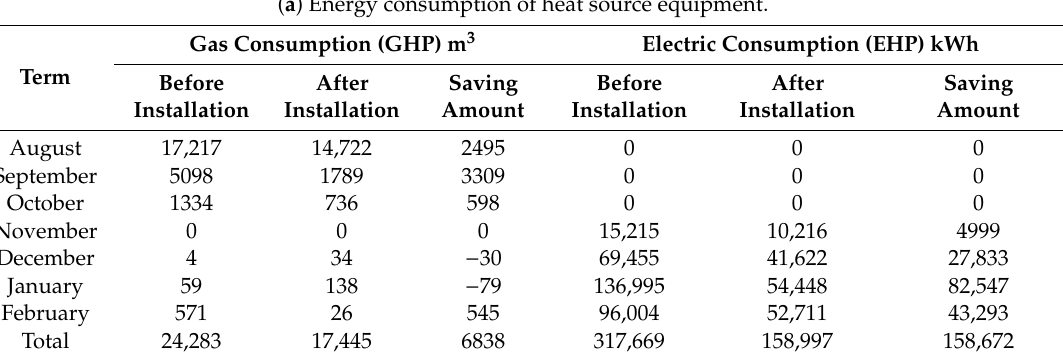
Table 4. Energy consumption before and after system